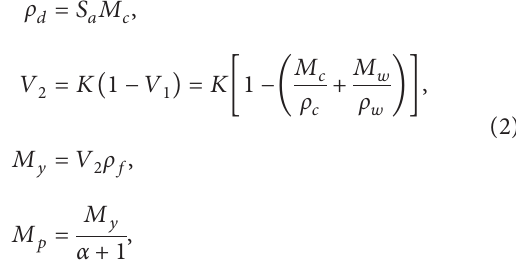
Figure 8: A composite supporting system containing FC [244].